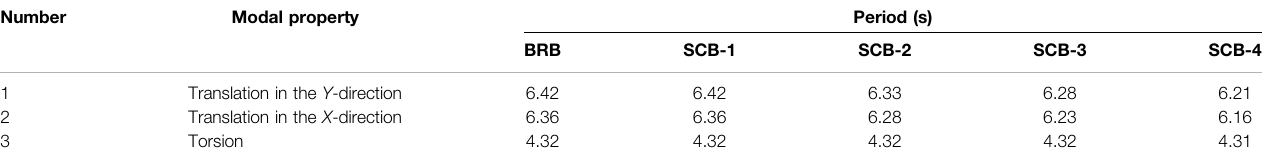
TABLE 5 | The fi rst three vibration modes of four cases.